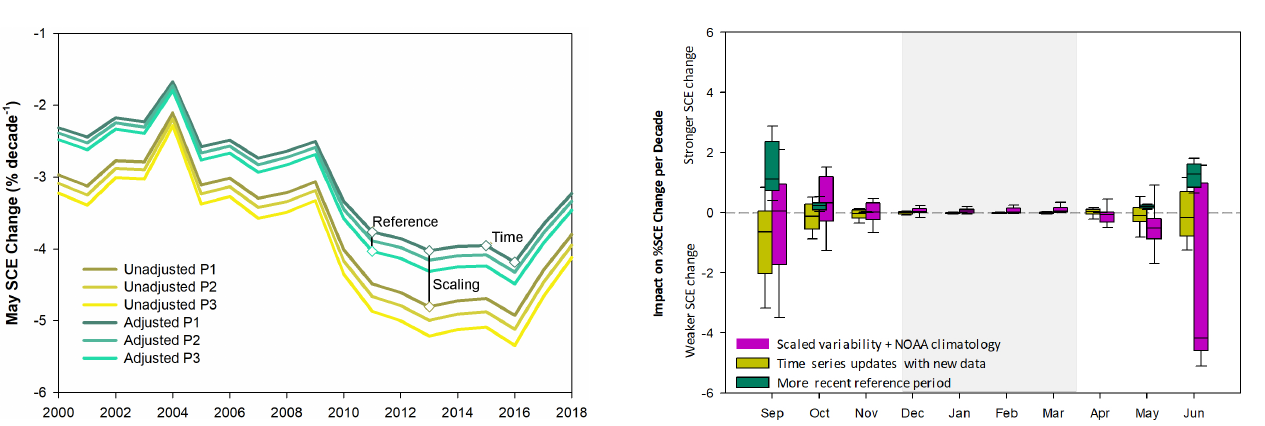
Figure 5. Sensitivity of Arctic snow cover extent rate-of-change calculations (expressed as percent per decade) to changes in the available time series length, selection of reference period, and the adjustment process. Values above zero indicate a stronger SCE rate of change; values below zero indicate a weaker SCE rate of